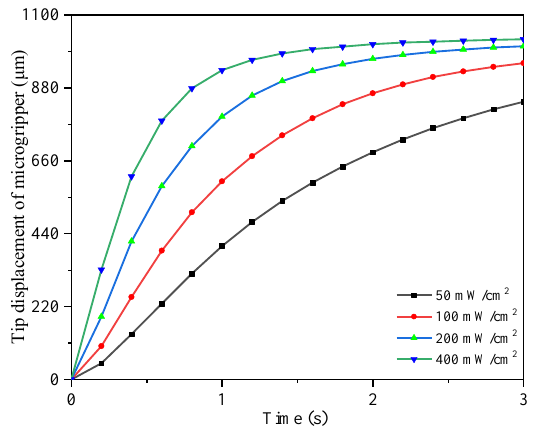
Figure 18. The static performance of the light-operated microgripper under irradiation with different intensities.